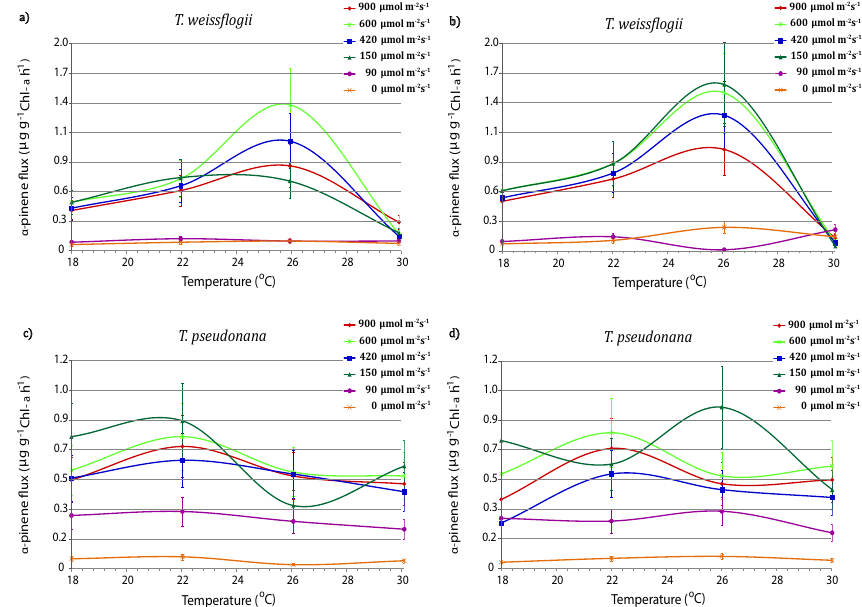
Figure 5. The 12h averaged α -pinene production rates (µg (gChl a ) − 1 h − 1 ) for the first (left column) and second (right column) light cycles as a function of temperature. Error bars denote the RSD Total value listed in Table